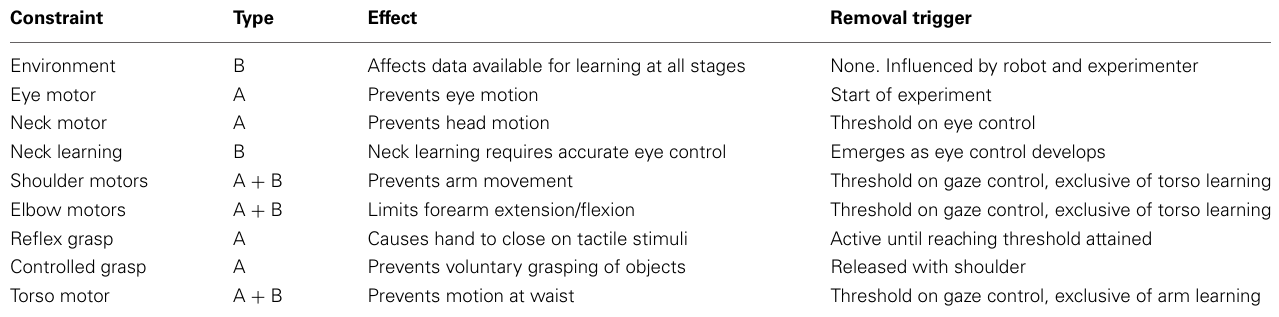
Table 3 | Constraints used to structure behavioral stages on the robot.